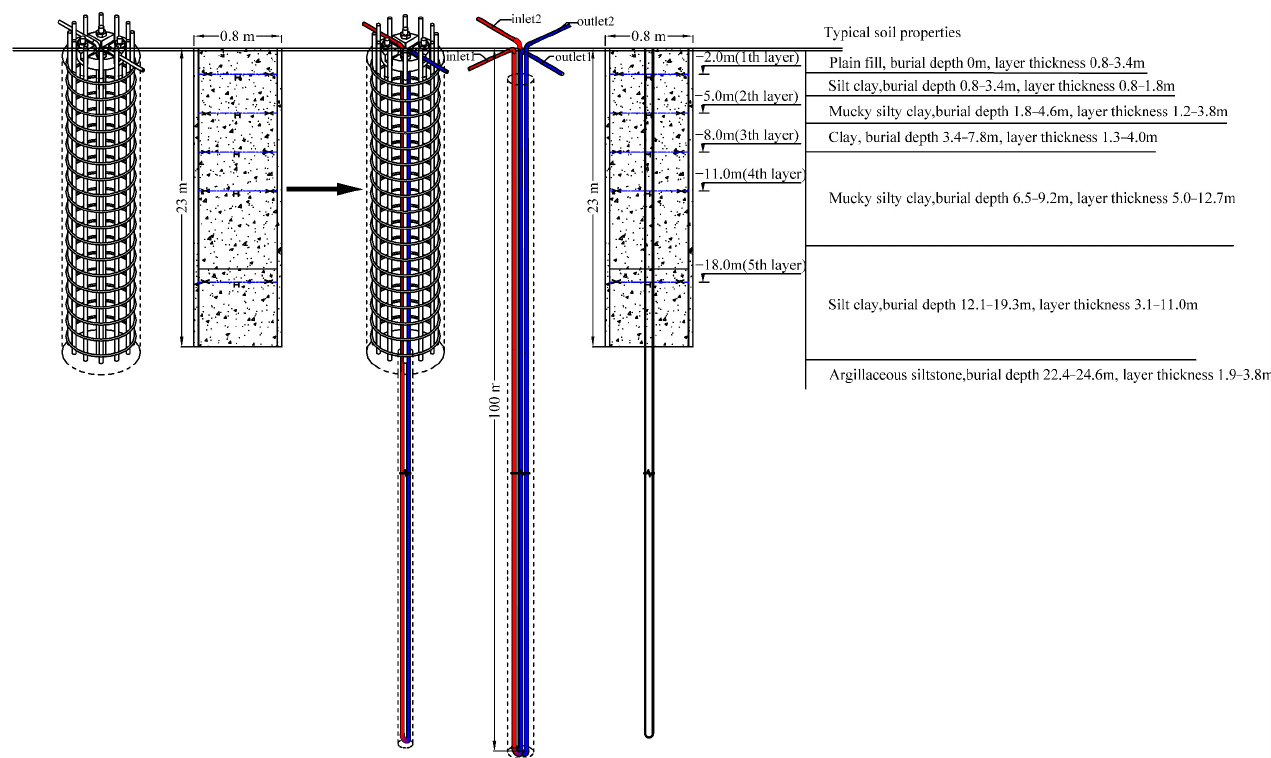
Figure 2. Soil layer distribution, test pile size and sensor-burying diagram.